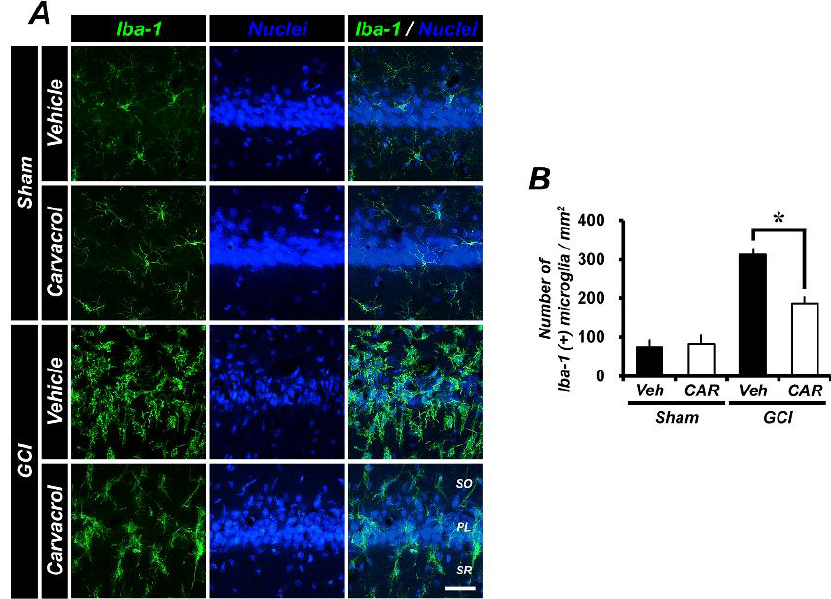
Figure 3. GCI-induced microglial activation by initiating inflammatory cascades was observed using ionized calcium-binding adaptor molecule (Iba1) staining (green signal), counter-stained with DAPI (sham vehicle: n = 5; sham carvacrol: n = 4; GCI vehicle: n = 5; GCI carvacrol: n = 5). ( A ) The sham-operated groups showed a microglia fluorescence signal, as well as the number of microglial cells in the hippocampal CA1 region associated with baseline resting conditions. Under the ischemic condition, the number of Iba1-positive microglial cells and the intensity of fluorescence signals were significantly increased. The group that underwent carvacrol administration after GCI showed reduced microglial activation. Scale bar = 50 μm. ( B ) The number of microglial cells in the hippocampal CA1 region. Data are the mean ± SEM, * p < 0.01.